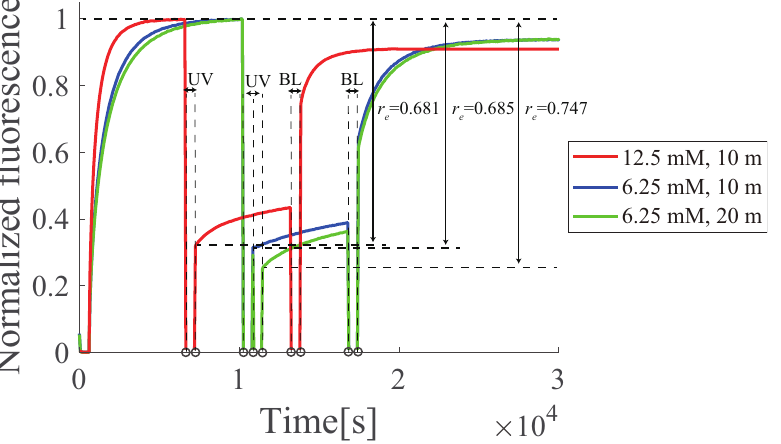
Figure 13. Effect of changing the buffer concentration on azobenzene. The red line shows 12.5 mM MgCl 2 , and the blue and green lines show 6.25 mM MgCl 2 . The blue line represent UV irradiation for 10 min and the green line for 20 min. The 12.5 mM experiments were averaged over three times, and the 6.25 mM experiments were conducted